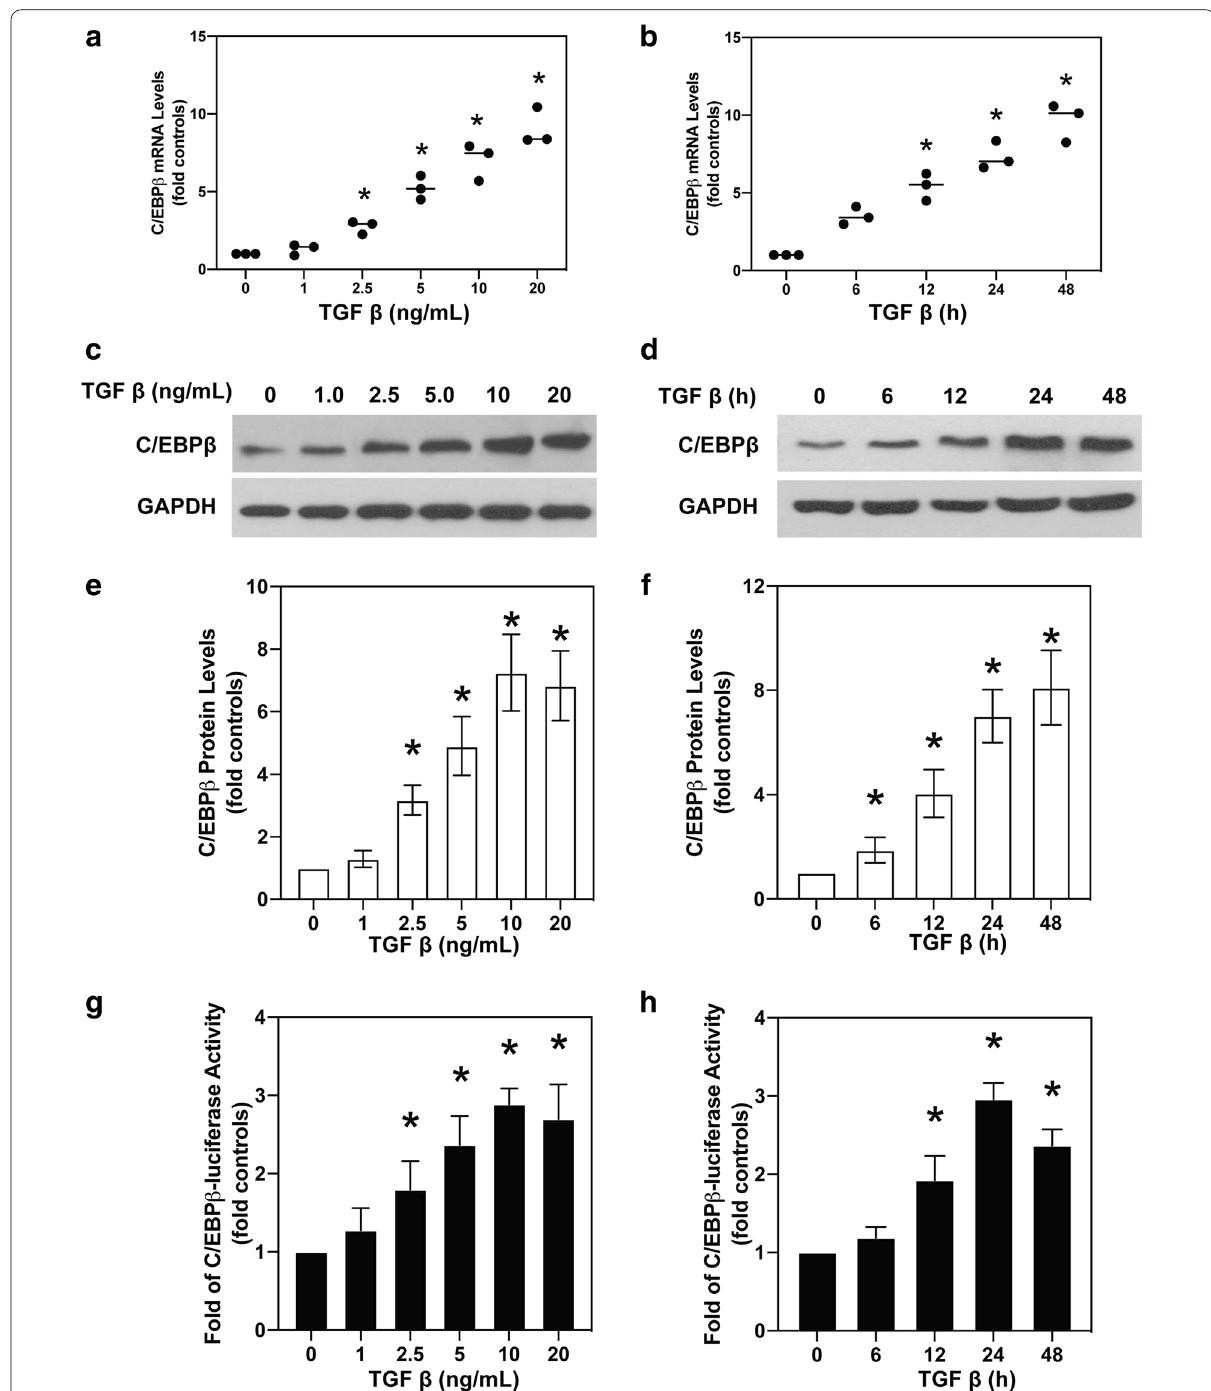
Fig. 2 (See legend on previous